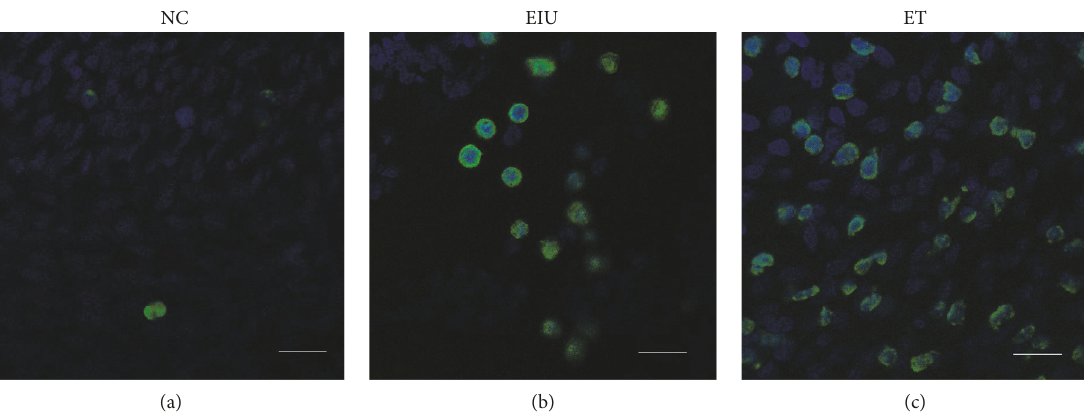
Figure 5: In the NC group, AKT distributed over cytoplasm (a). In the EIU group, AKT transferred from cytoplasm to cell membrane (b). In the ET group, translocation of AKT was inhibited partially (c). Scale bars: 50 μ